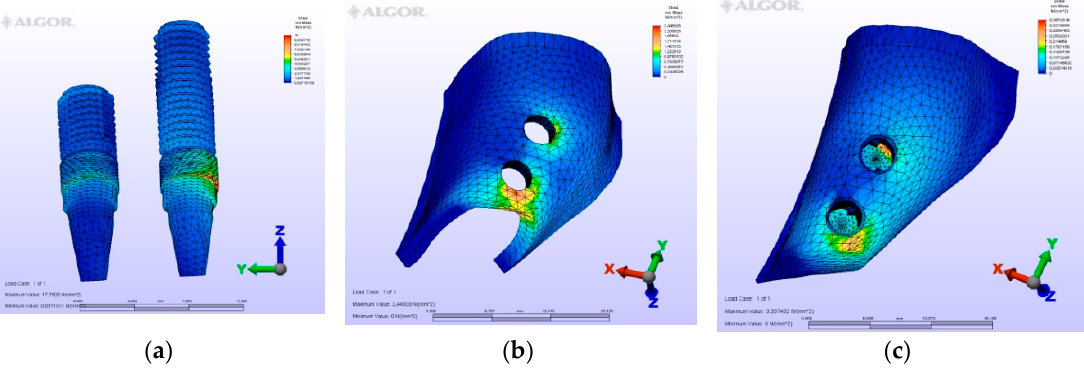
Figure 13. M4, horizontal loading, ( a ) the maximum von Mises stresses around implants; ( b ) maximum principle stress in cortical bone; ( c ) maximum principle stress in cancellous bone.